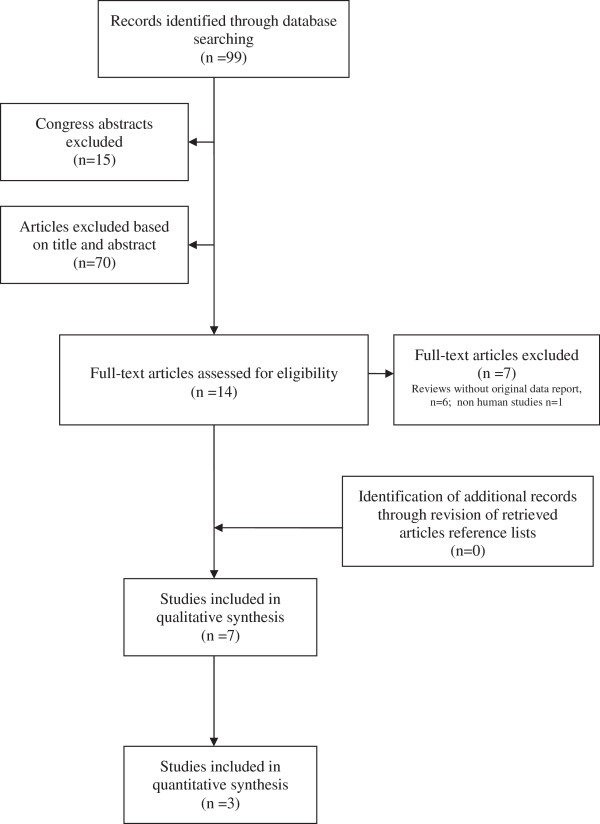
Flow diagram of the complete study selection process.